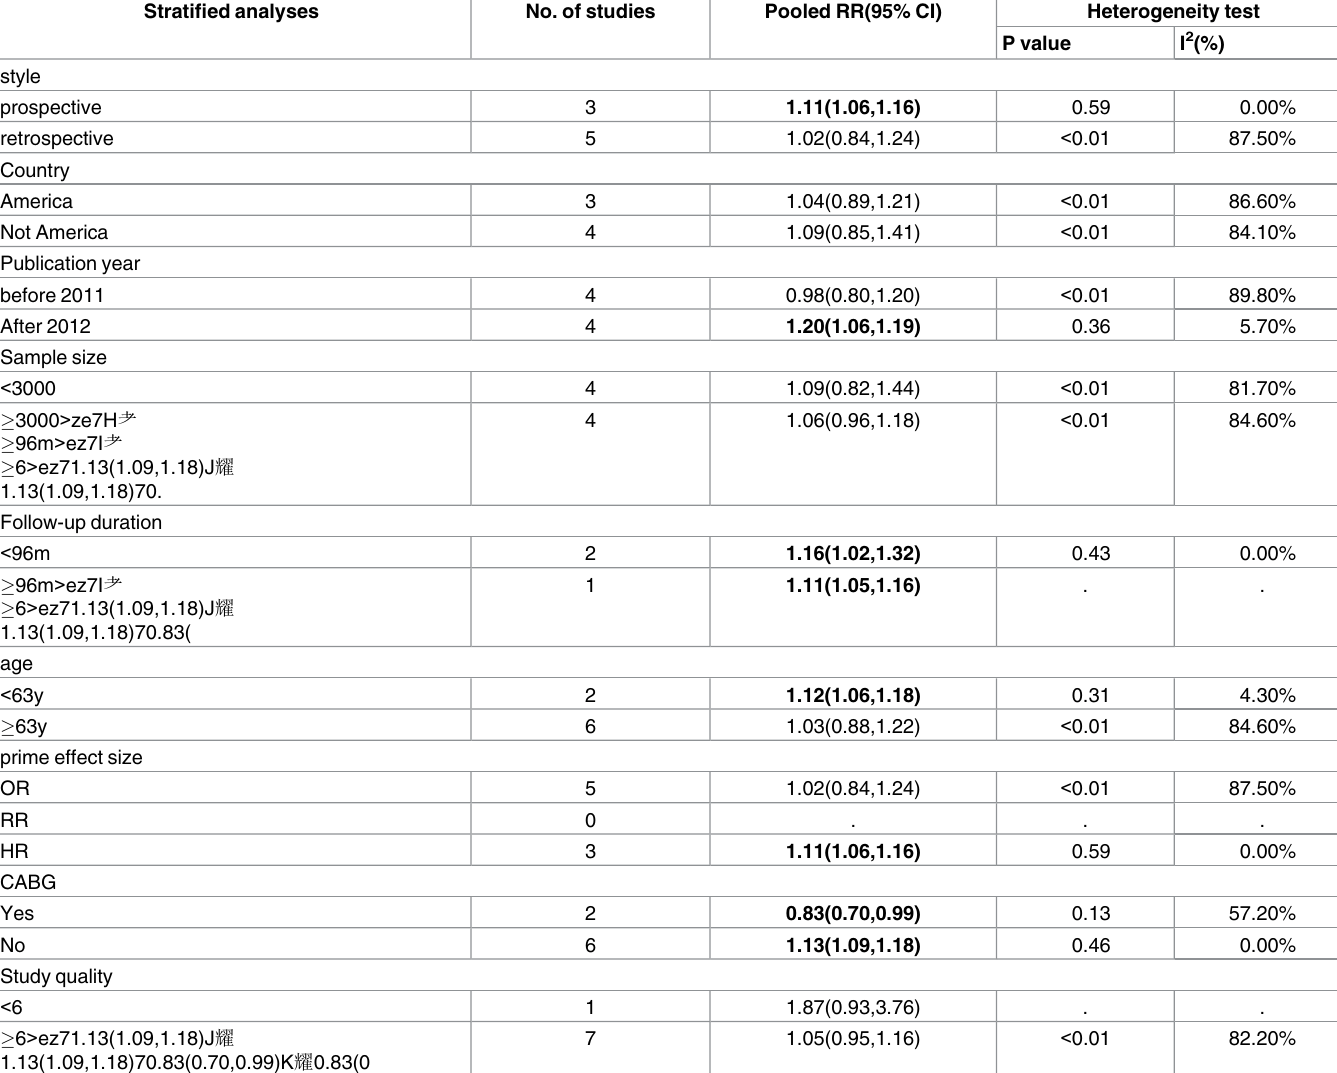
Table 2. Stratified analysesof pooled relative risks (95% CI) of AF for HbA1c levels as continuous